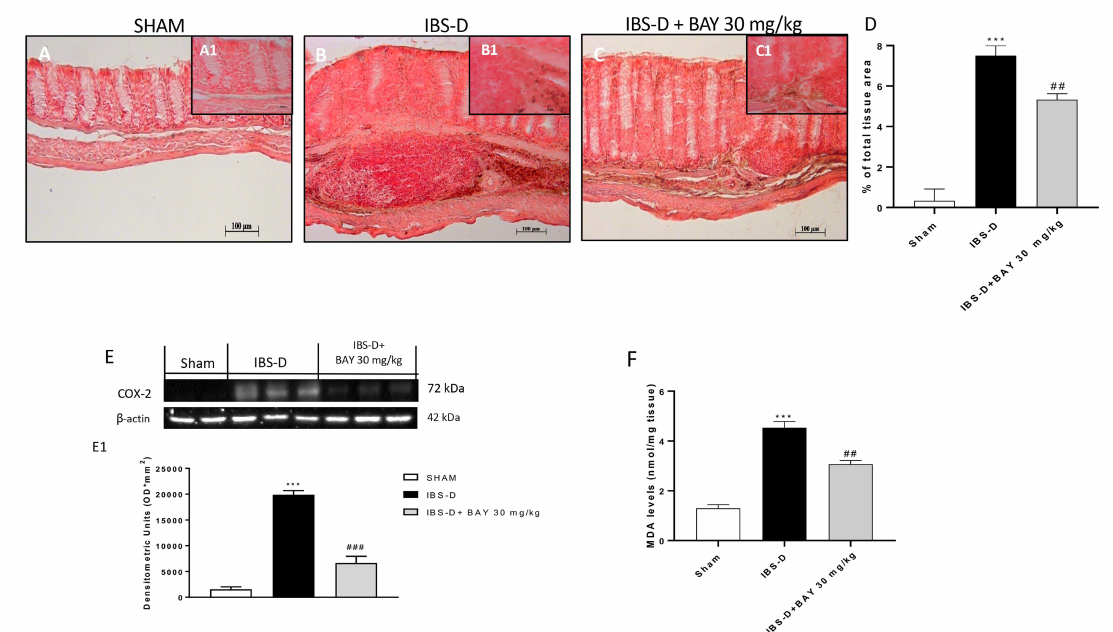
Figure 8. E ff ect of BAY 11-7082 treatment on lipid peroxidation and COX-2 expression. Immunohistochemical analysis revealed an increase of the COX-2 level in IBS-D groups ( B ) compared to the sham group ( A ). Moreover, BAY treatment 30 mg / kg significantly decreased COX-2 levels ( C ). Data were confirmed by Western blot analysis, showing a decrease of COX-2 levels in the IBS-D group following BAY treatment 30 mg / kg. In addition, BAY treatment 30 mg / kg reduced MDA levels compared to the IBS-D group as shown in ( F ). Data are representative of at least three independent experiments. ( D ) *** p < 0.001 vs. Sham. ## p < 0.01 vs. IBS-D. ( E ) *** p < 0.001 vs. Sham. ### p < 0.001 vs. IBS-D. ( F ) *** p < 0.001 vs. Sham. ## p < 0.01 vs.